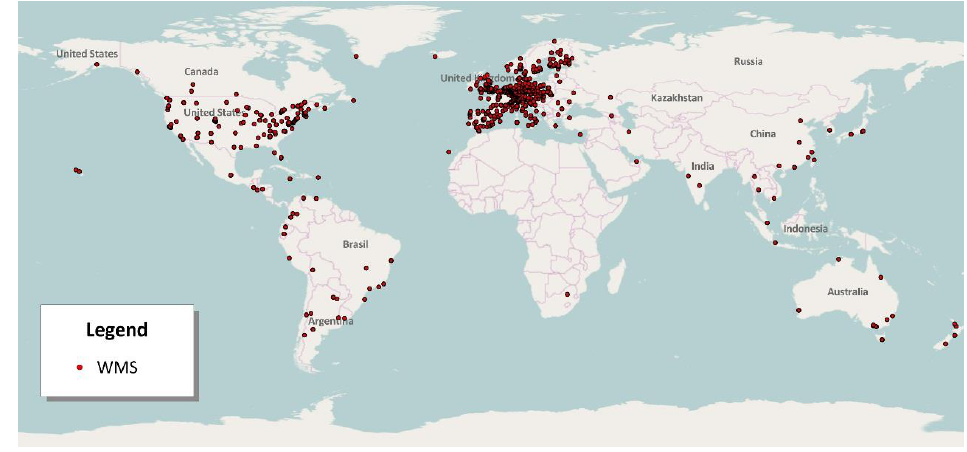
Figure 5. The geo-location of monitored public WMSs.